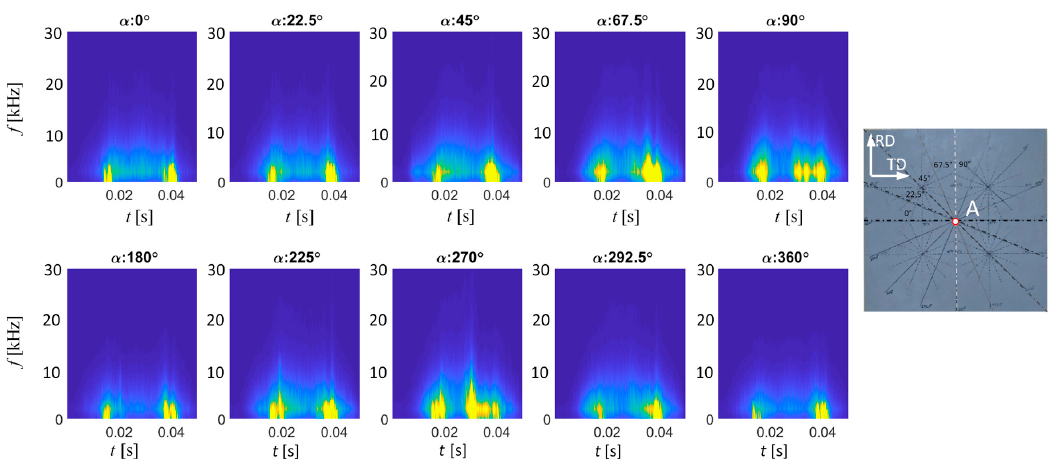
Figure 7. BN TF_S spectrograms distributions obtained for various orientation of the transducer over location A in the sample.